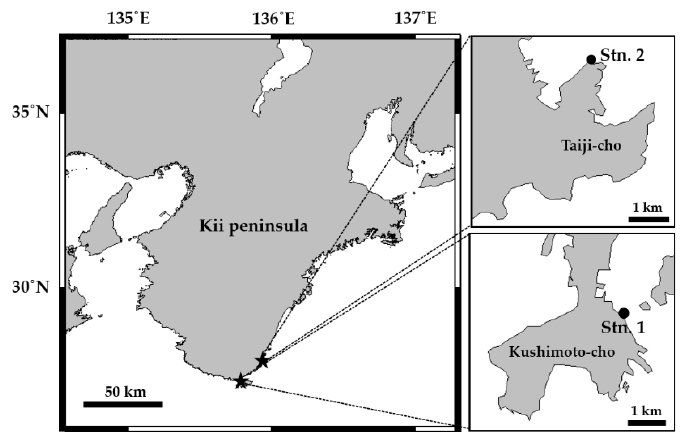
Figure 1. Location of the installation of artificial Ulva bed (Stn. 1) and the natural macroalgal bed (Stn. 2) at Kushimoto-cho and Taiji-cho, Wakayama Prefecture, Japan.